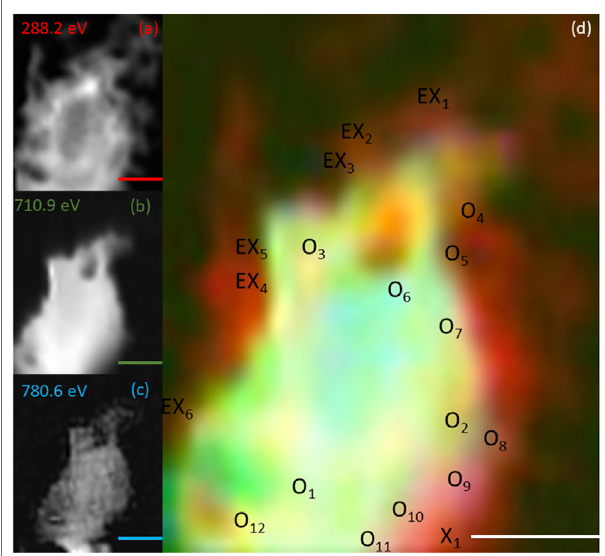
FIGURE 6 | Elemental maps for the 9 h timepoint for (A) C K -edge (288.2 eV; red), (B) Fe L 2,3 -edge (710.9 eV; green) and (C) Co L 2,3 -edge (780.6 eV; blue). The corresponding composite RGB (red, green, blue) image (D) shows the spatial relationship between the bacterial cells (C K -edge) andtheminerals(FeandCo L 2,3 -edges).Spectraweretakenfromregionsco- located with the bacterial cells (X) and regions not co-located to the bacterial cell (O). The centre of the ‘ X ’ and ‘ O ’ denote the precise location from which the spectra were collected. All scale bars are 2 μ